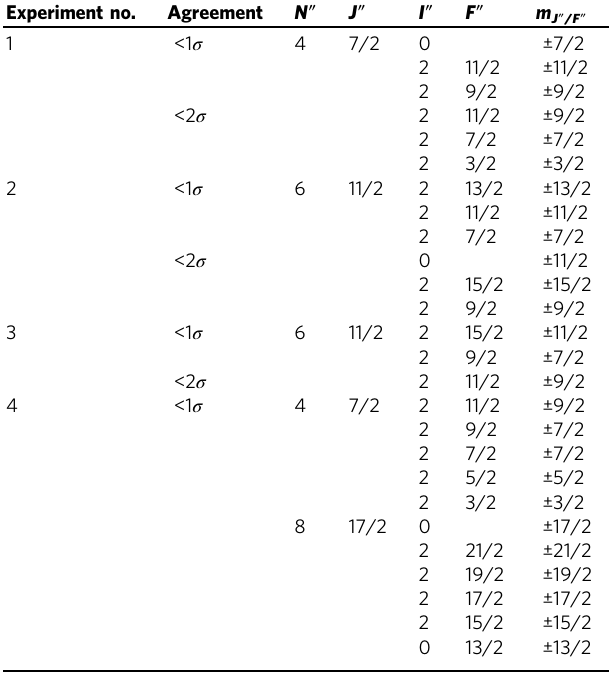
The numbers in the fi rst column correspond to the labels shown in Fig. 4. The second column indicates the level of agreement between experiment and theory for the given state (for experiment 4, only states within 1 σ agreement are given. An additional 20×2 states within 2 σ agreement are omitted). N ″ , J ″ , I ″ , F ″ and m J ″ / F ″ stand forthe rotational, spin – rotational,nuclear- spin, hyper fi ne and magnetic quantum numbers of N in the electronic and vibrational ground